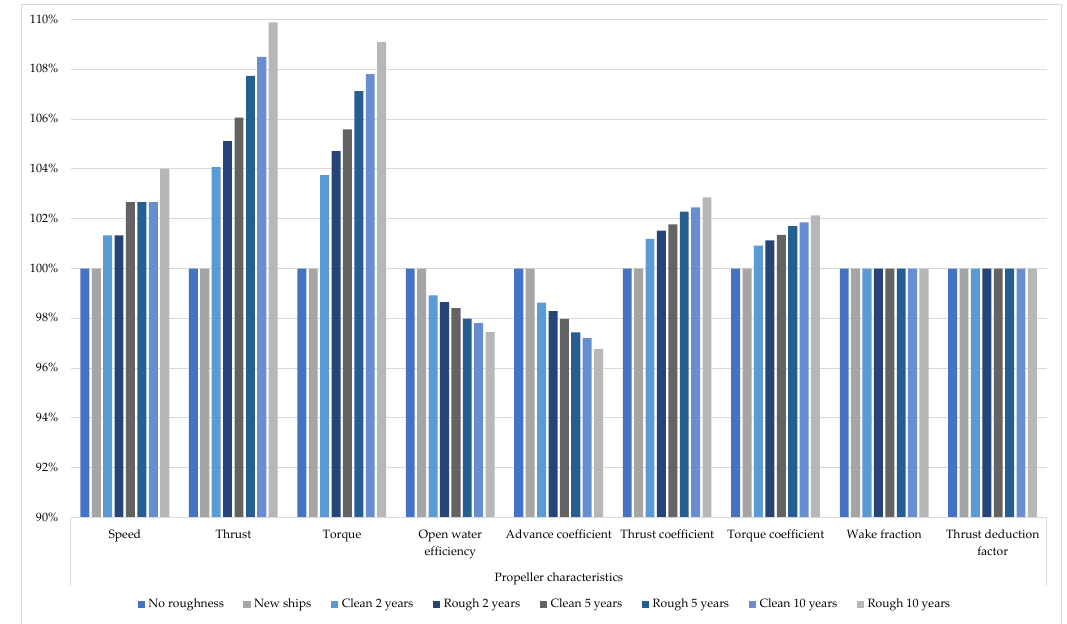
Figure 2. Percentage changing propeller characteristics for different hull roughness.